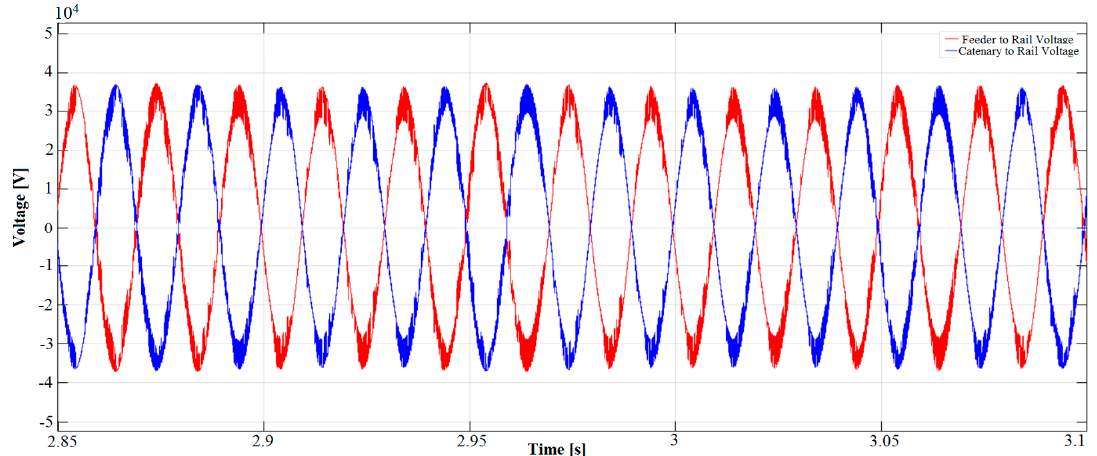
Figure 15. Catenary and feeder voltages on the charging facility connection point.